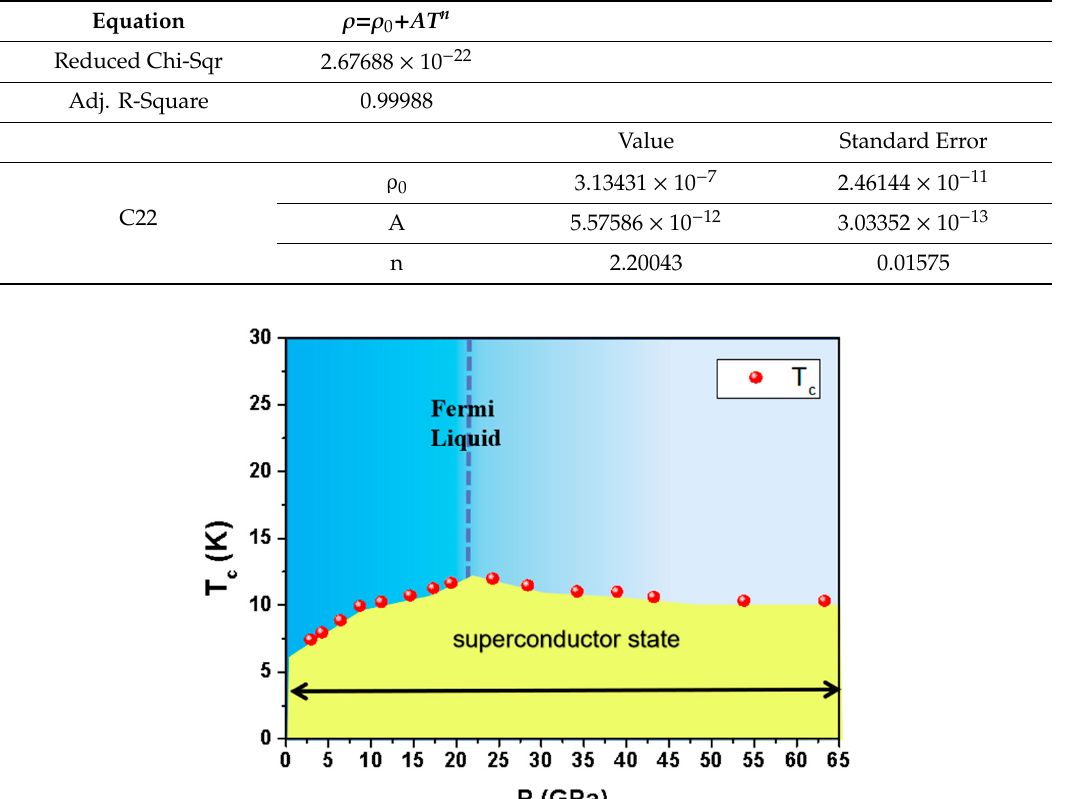
Figure 8. Superconducting phase diagram of La as a function of pressure. The dotted blue line shows the Fermi liquid behavior ( n = 2) at a normal state. The normal state ranges from n ~1.8 at ambient pressure to n ~2.6 at 63 GPa.